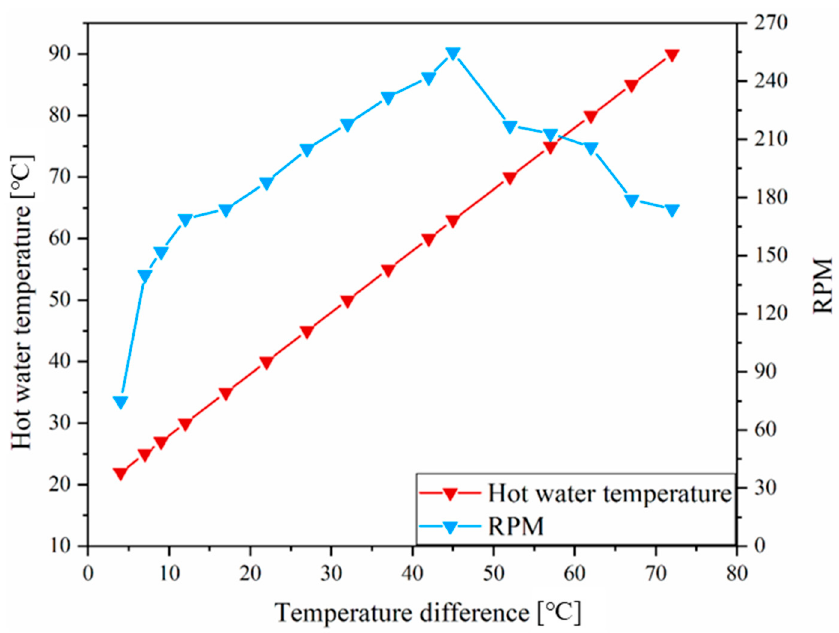
Figure 10. The effect of temperature difference on RPM of the hybridized EMG/TENG with a horizontal configuration.